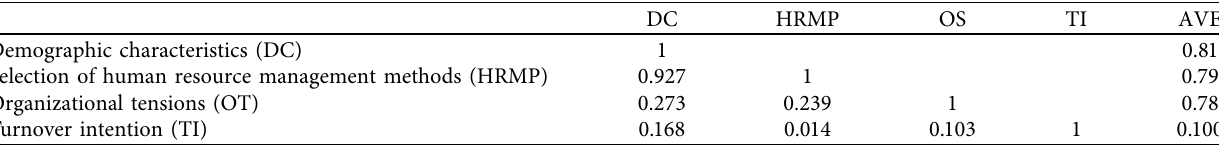
Table 3: Correlation matrix and divergent validity